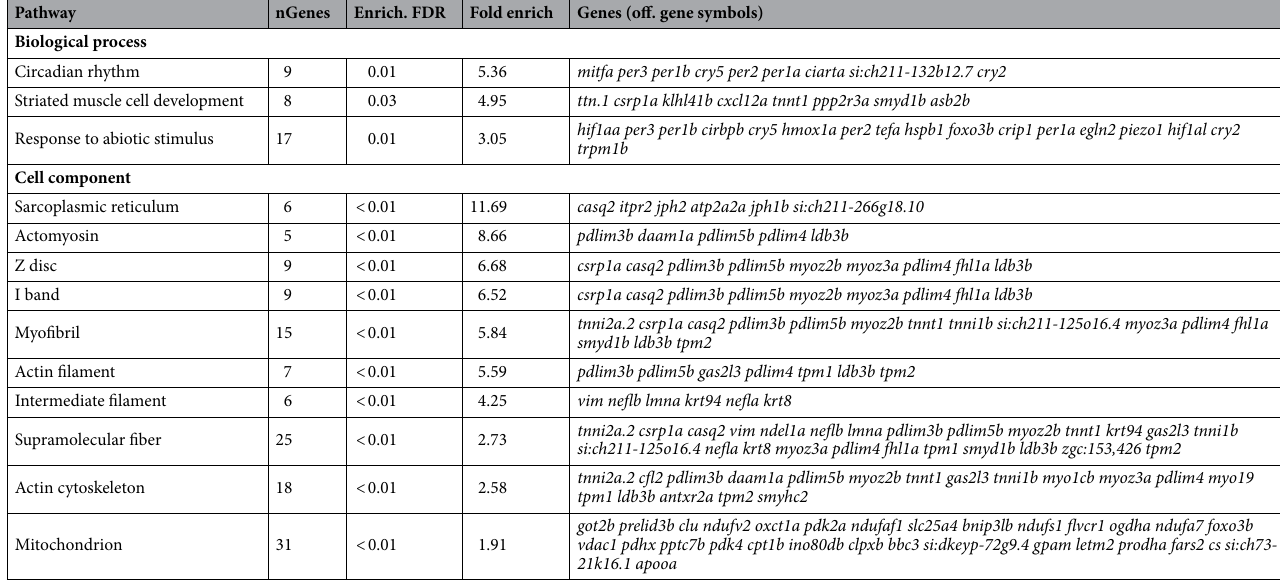
Table 2. Enriched GO (biological processes, FDR < 0.01) associated with genes significantly up- expressed in the heamal region in the recovered individuals